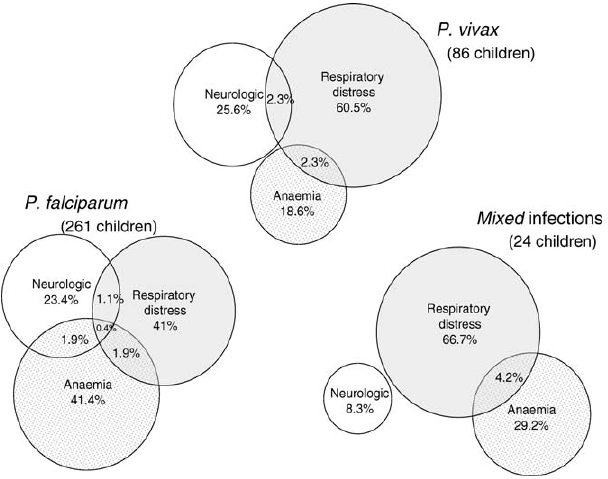
Figure 5. Total Parasite Densities in Uncomplicated and SM by Species (Children , 5 y) Line is median, boxes are 25th and 75th percentile, and whiskers are upper and lower adjacent